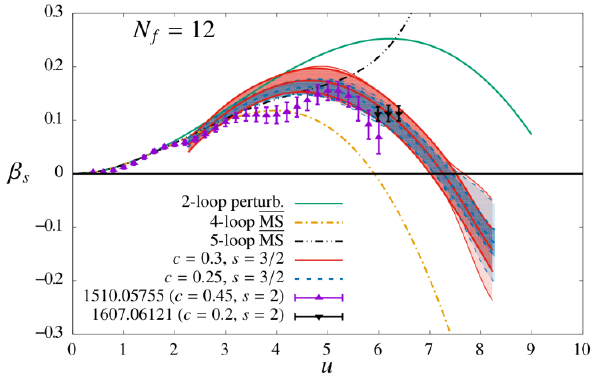
Figure 5 . Comparison of our discrete (cid:12) function results with data from refs. [34] and [35] at . 6 : 4. All four data sets use the clover discretization of E ( t ) but di(cid:11)erent gradient couplings g 2 c (cid:13)ow renormalization schemes: we overlay our c = 0 : 25 (dashed blue) and c = 0 : 3 (solid red) results (both with (cid:28) opt = 0 : 08 and scale change s = 3 = 2) along with c = 0 : 45 results from ref. [34] and c = 0 : 2 results from ref. [35] (both with s = 2). Given the di(cid:11)erent renormalization schemes and analysis details the results are all in good agreement. (The perturbative curves continue to use s = 3 = 2 as in (cid:12)gure